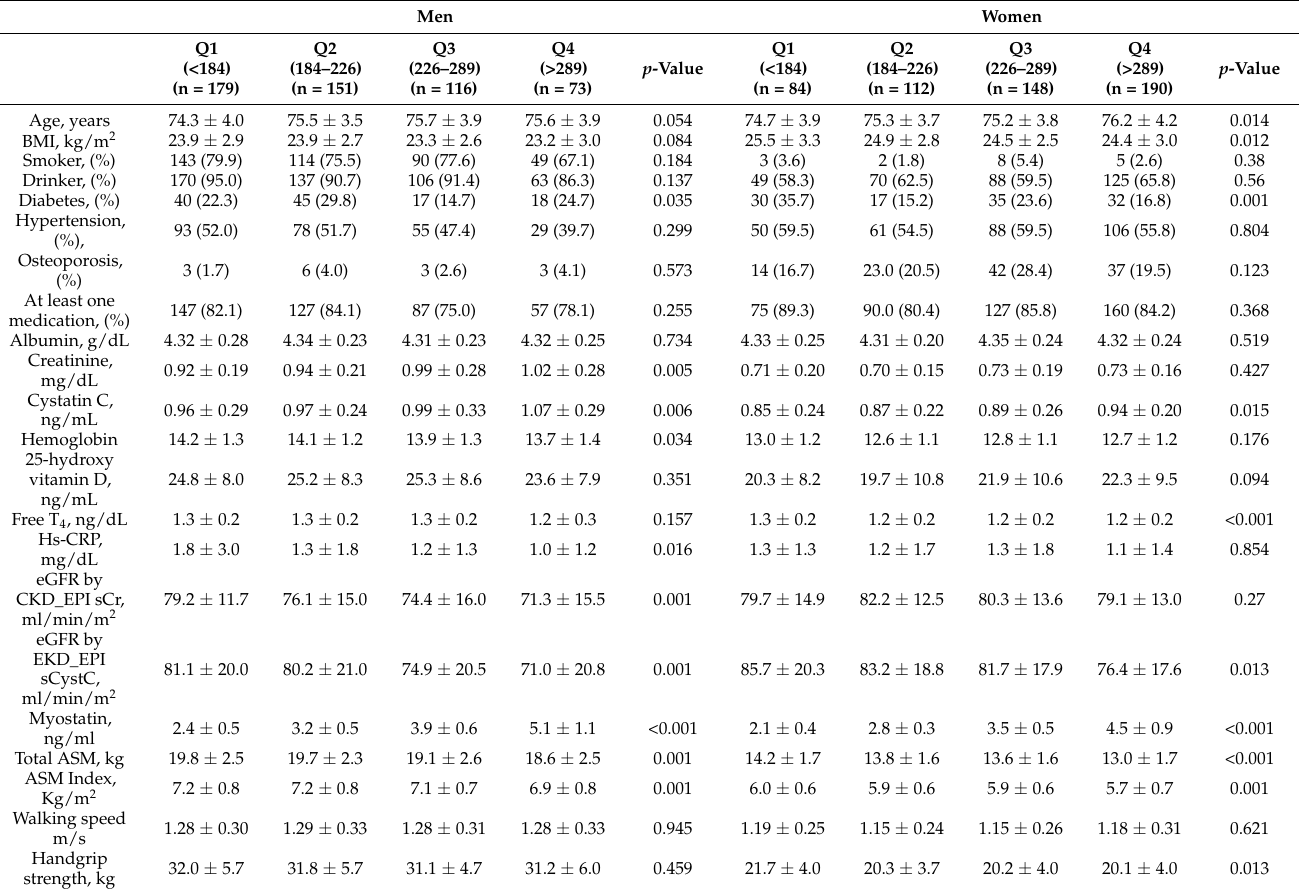
Table 3. Characteristics according to plasma myostatin/ASM ratio in 519 men and 534 women. Men Women